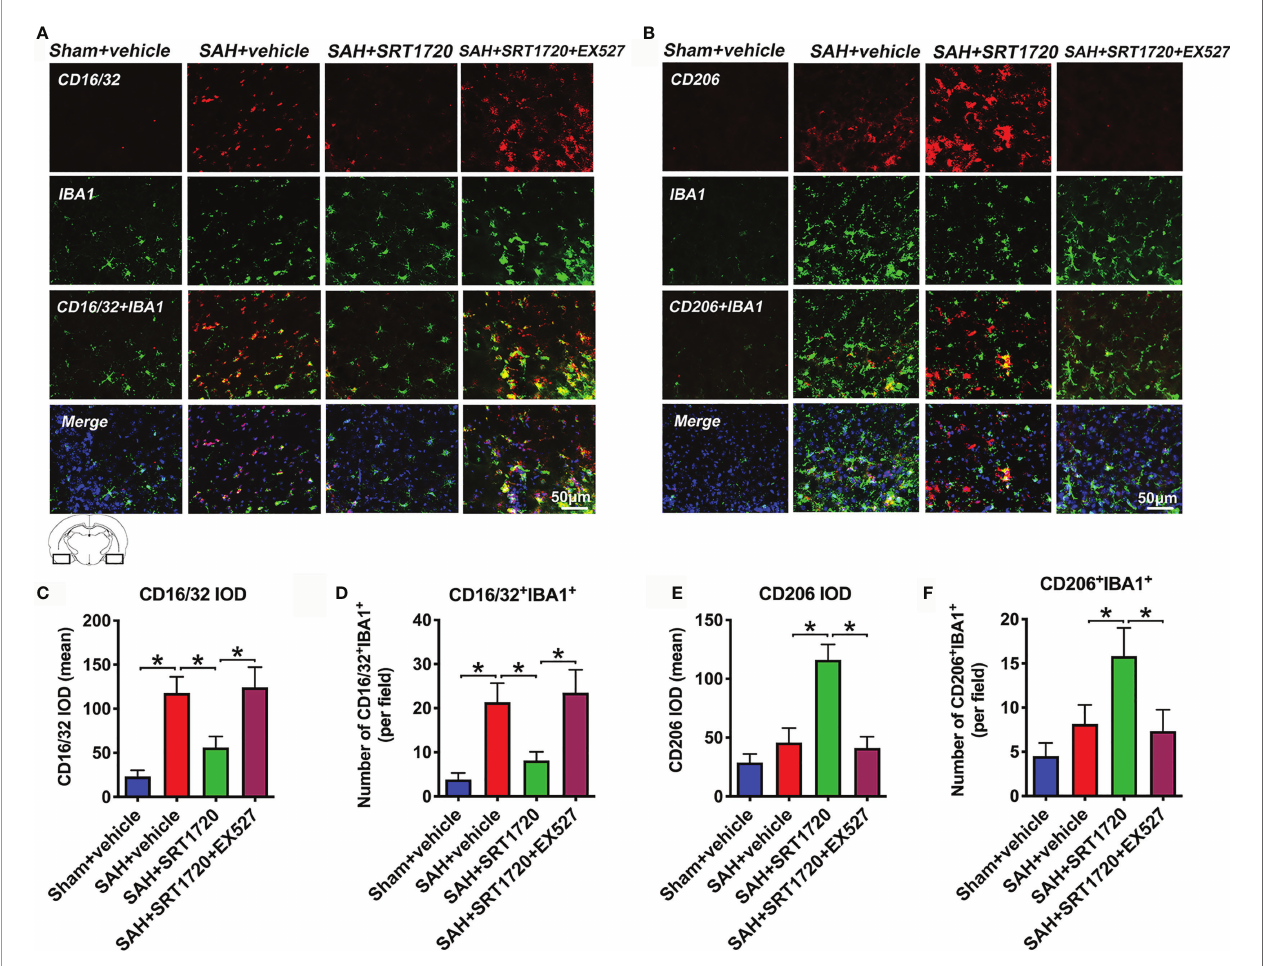
FIGURE 5 | Effects of SRT1720 on microglia phenotypic transformation after SAH. Representative immuno fl uorescence staining images of M1 phenotype (A) and M2 phenotype (B) , and its quanti fi cation analysis (C – F) . For histopathology studies, the basal temporal lobe adjacent to the clotted blood was evaluated. Bars represent the mean ± SD. * P <